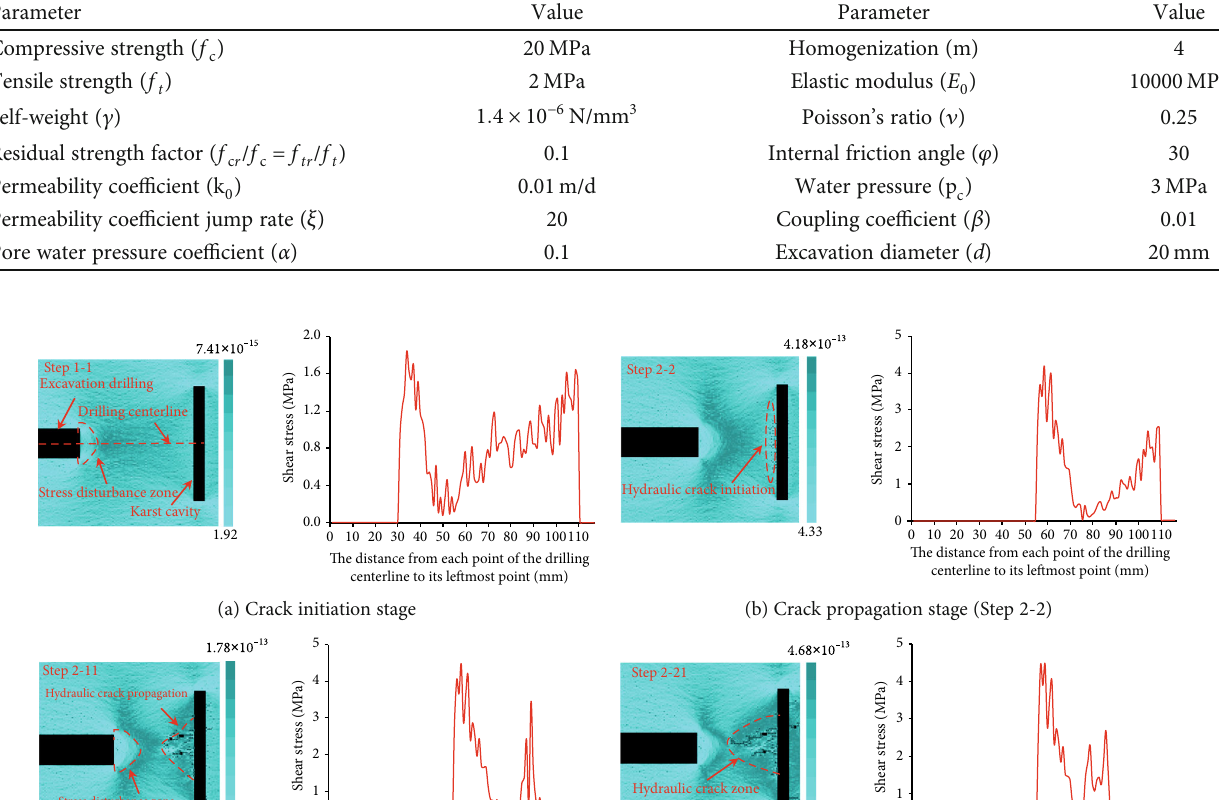
Table 1: Numerical simulation parameters.